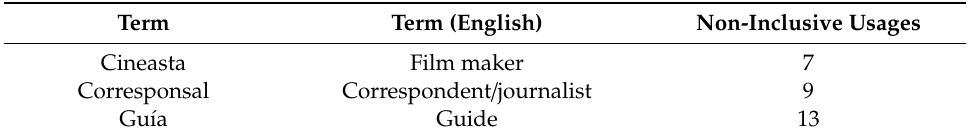
Table 13. Evaluating